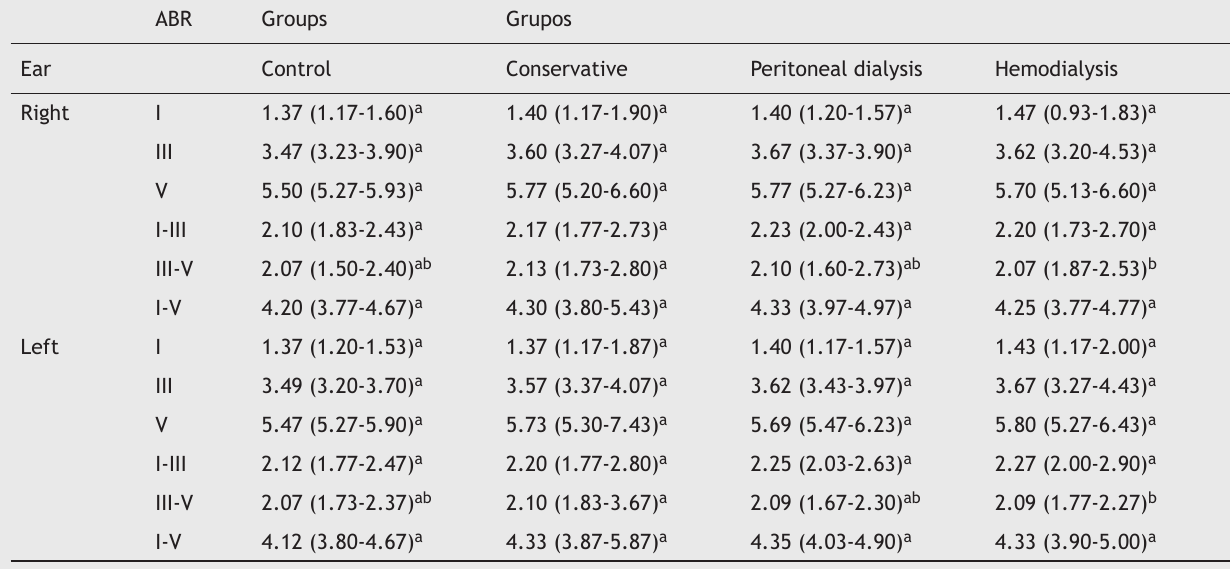
Table 3 Comparison of the parameters of the brainstem auditory response (ABR) in each ear according to group. ABR Groups Grupos